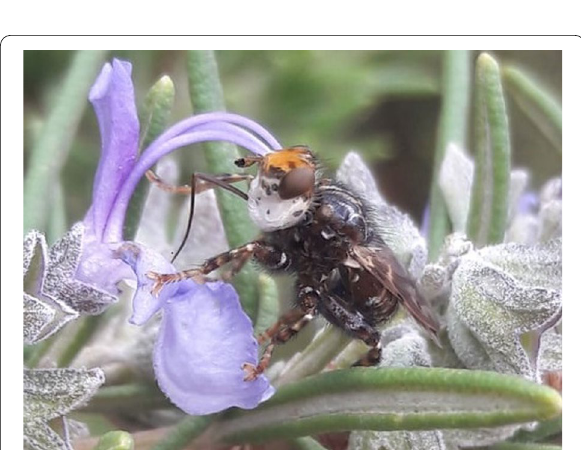
Fig. 4 Myopa picta Panzer on Salvia